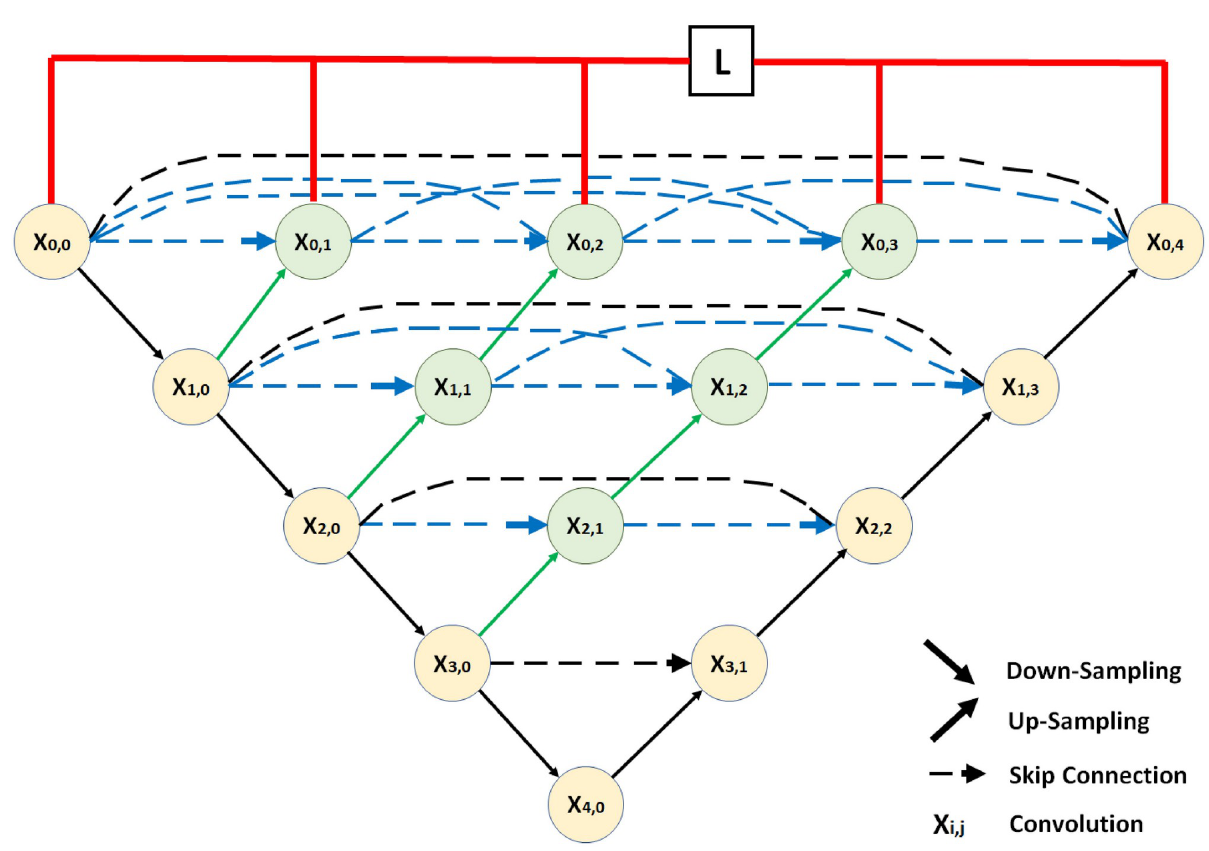
Fig 6. Basic U-Net++